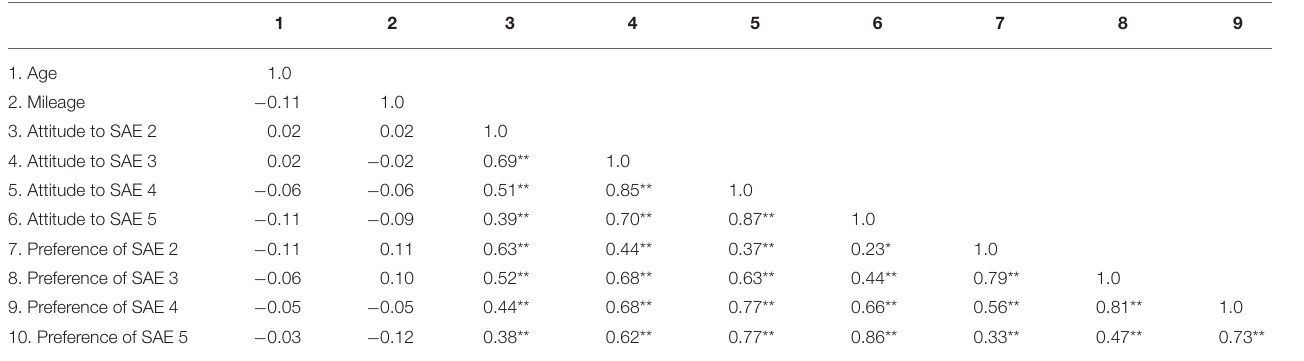
TABLE 1 | Correlations between background variables, attitudes, and SAE